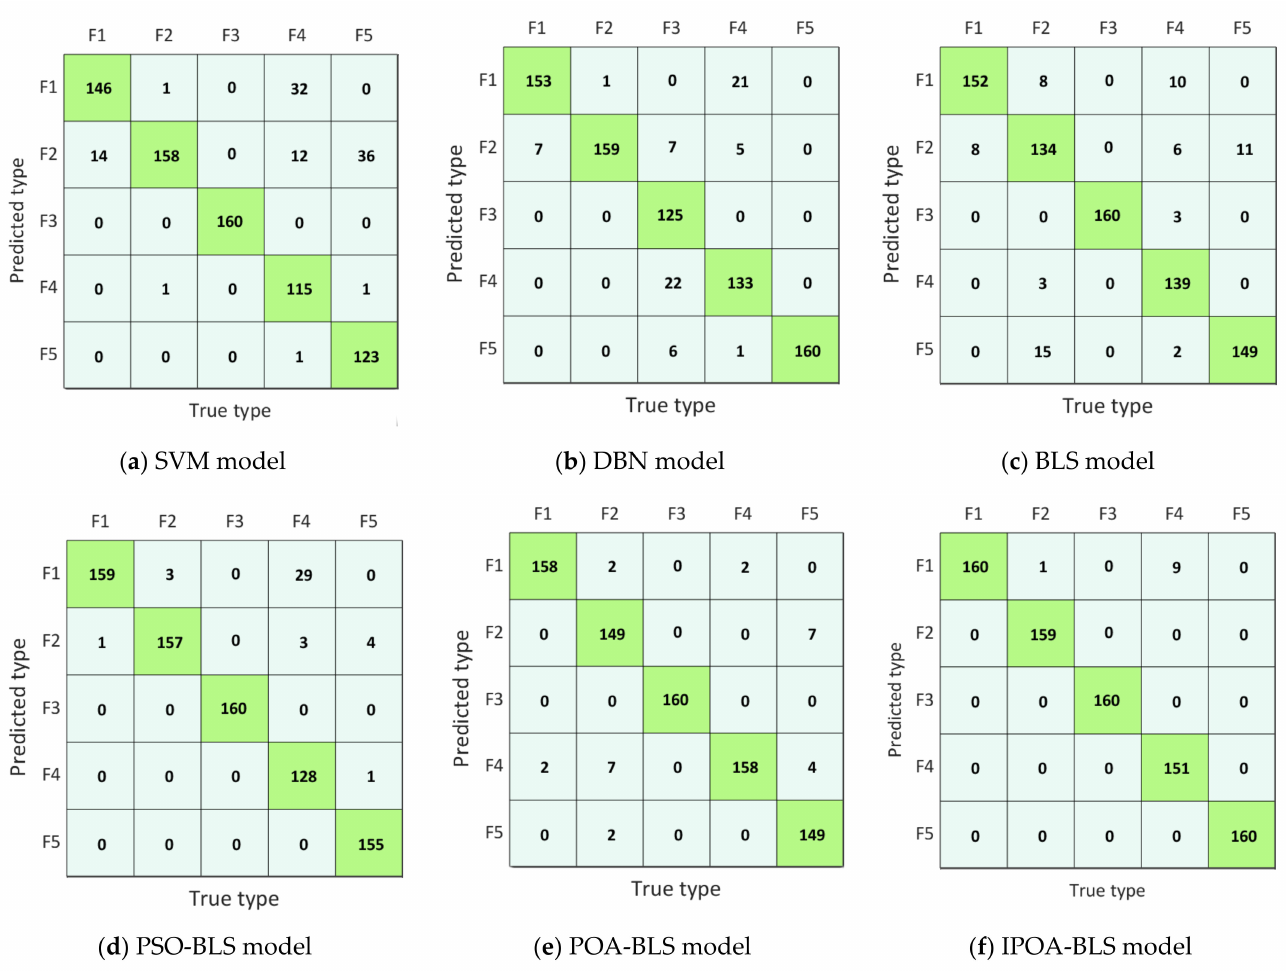
Figure 7. Confusion matrices of the different